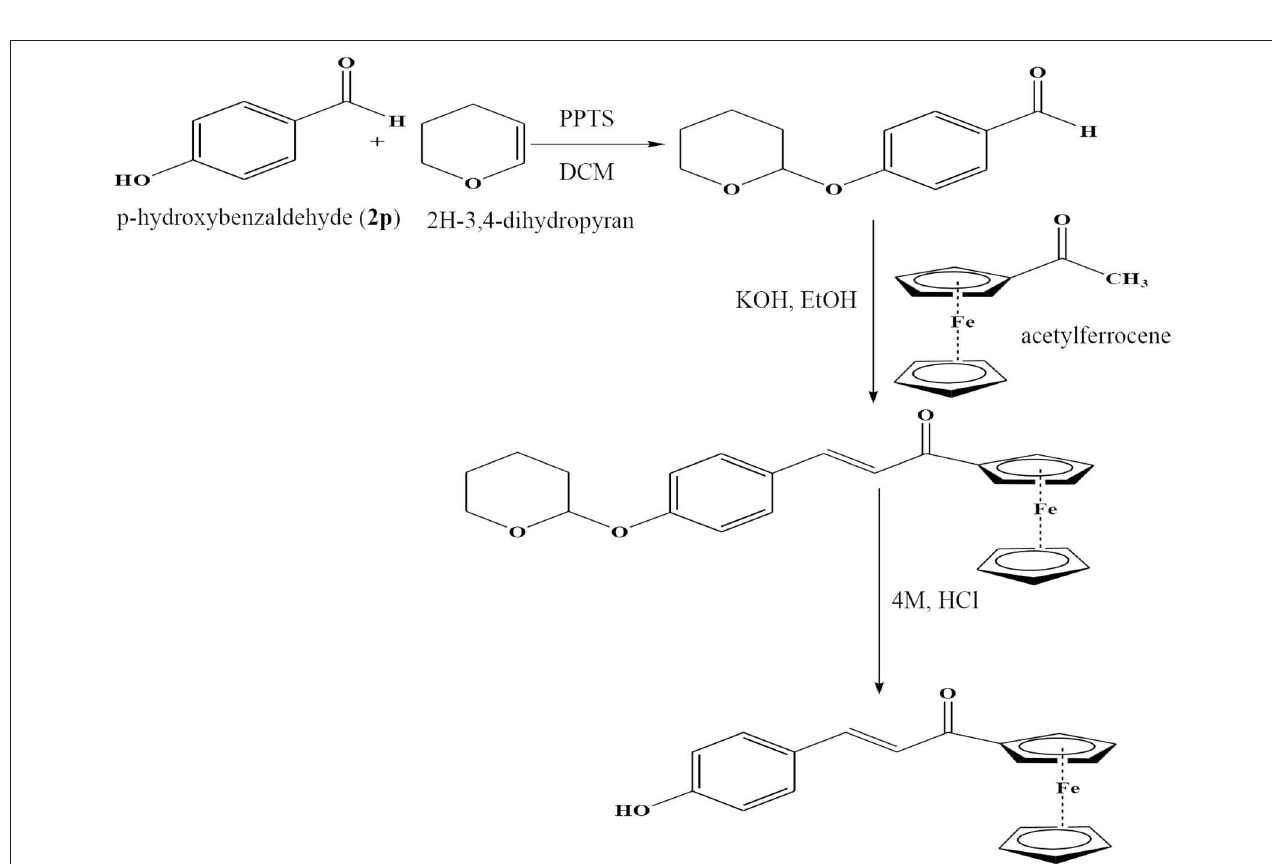
(2E)-1-Ferrocenyl-3-(4-methoxyphenyl) prop-2-en-1-one